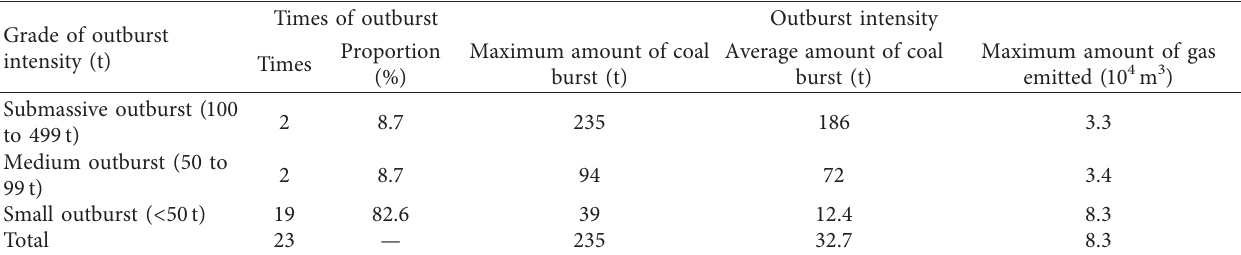
Table 1: Statistics pertaining to times and intensity of outbursts in the mine.